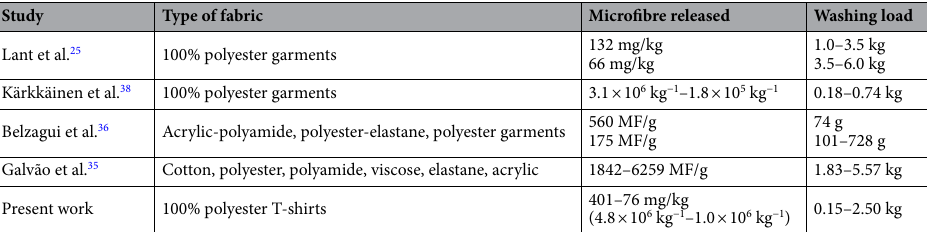
Table 1. Comparison of the results of the present work with previous studies on microfibre release as a function of washing